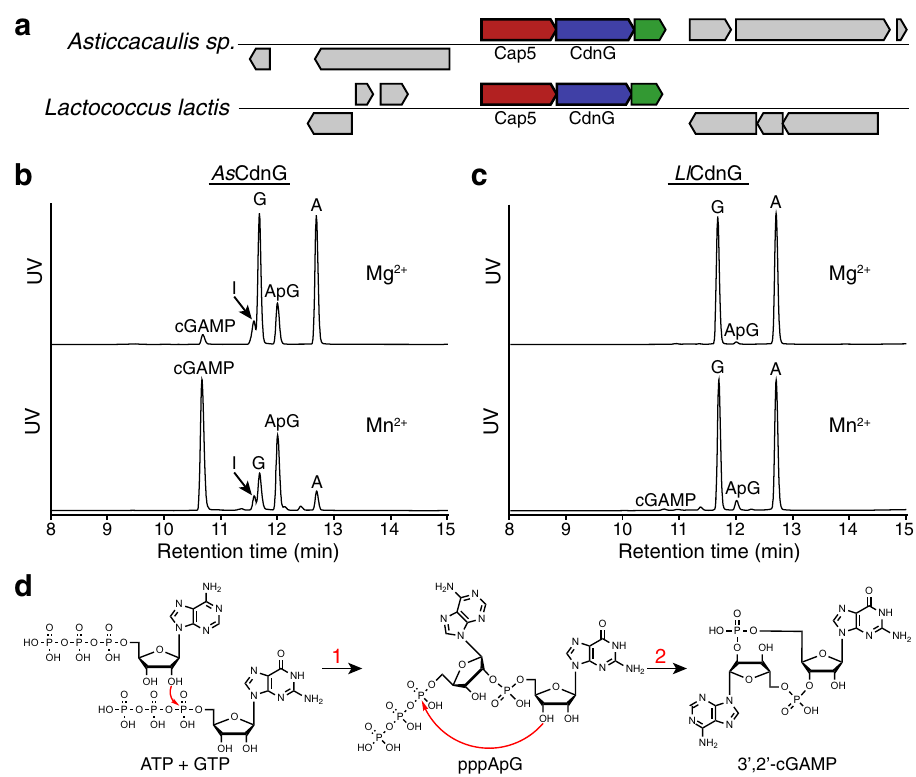
Fig. 1 In vitro reconstitution of the enzymatic activity of CdnG. a Schematic view of two operons encoding CdnG-Cap5 antiphage defense system. In addition to the genes encoding Cap5 and CdnG, a third gene encoding a conserved protein of unknown function might also be part of the operon (colored green). b UPLC analysis of the reaction mixtures carried out by As CdnG. ApG is presumably the dephosphorylated product of the reaction intermediate pppApG. I, Inosine, which is presumably the dephosphorylated product of ITP resulting from deamination of ATP. Results are representative of three